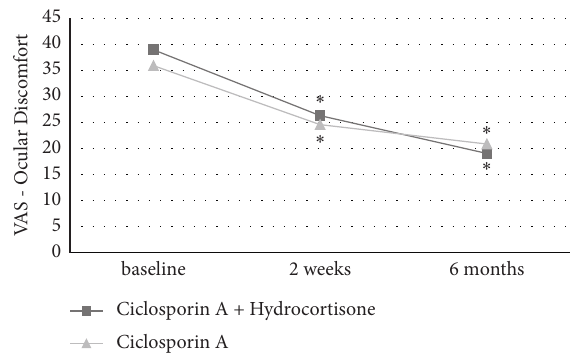
Figure 1: Visual Analogue Scale (VAS) of subjective ocular dis- comfort in both treatment groups at baseline, after 2 weeks, and after 6 months of treatment. Significant differences to baseline are marked with ∗ .